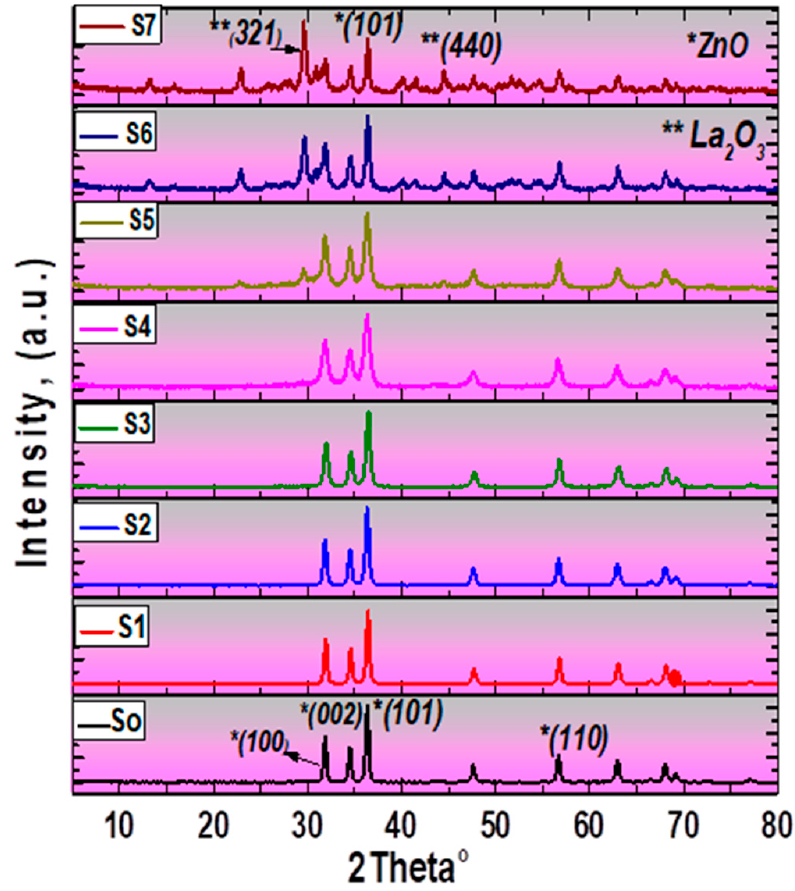
Figure 1. XRD patterns La 2 O 3 -ZnO nanostructured composites (S1–S7).